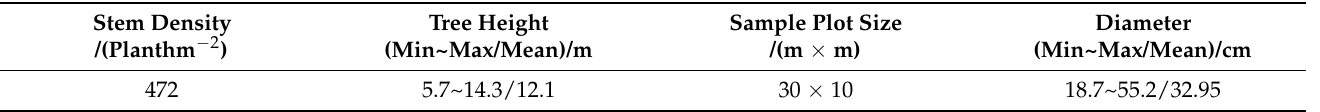
Table 1. Sample site overview.